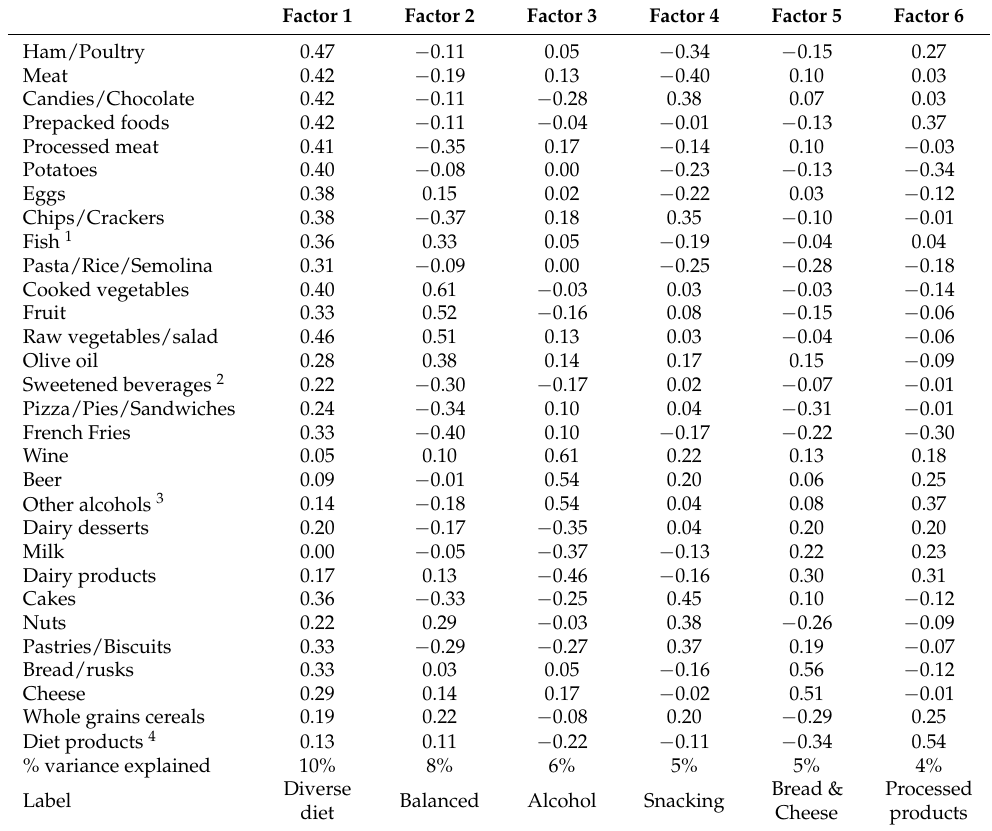
Table 1. Factor loadings for dietary patterns before pregnancy, derived from principal component analysis ( n = 998): the ELFE study,